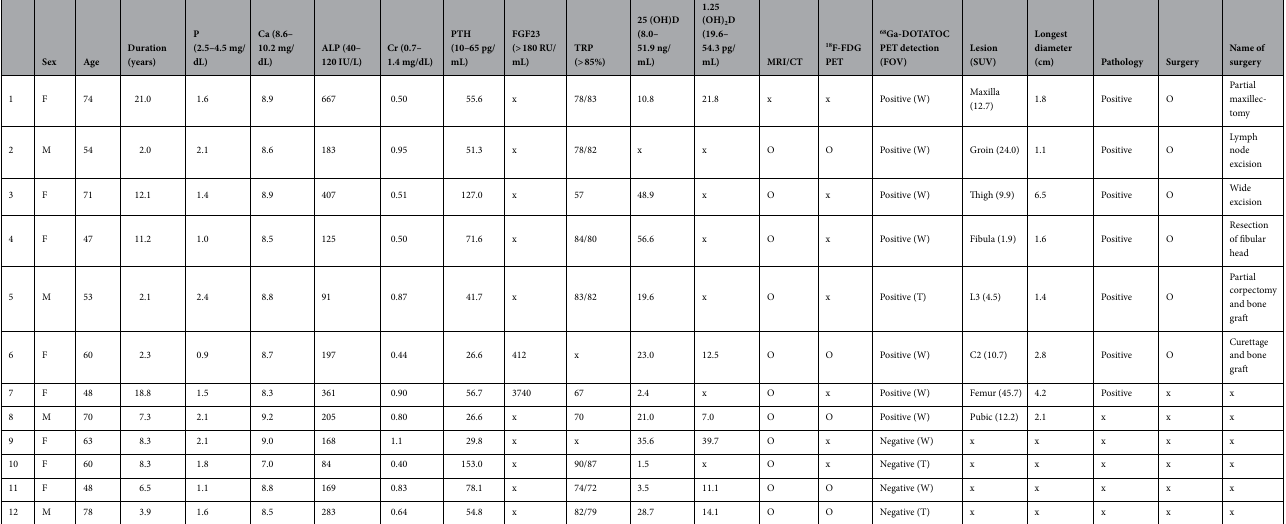
Table 1. Patient characteristics. P phosphorous, Ca calcium, ALP alkaline phosphatase, Cr creatinine, PTH parathyroid hormone, FGF-23 fibroblast growth factor-23, TRP tubular reabsorption of phosphate, 25(OH)D